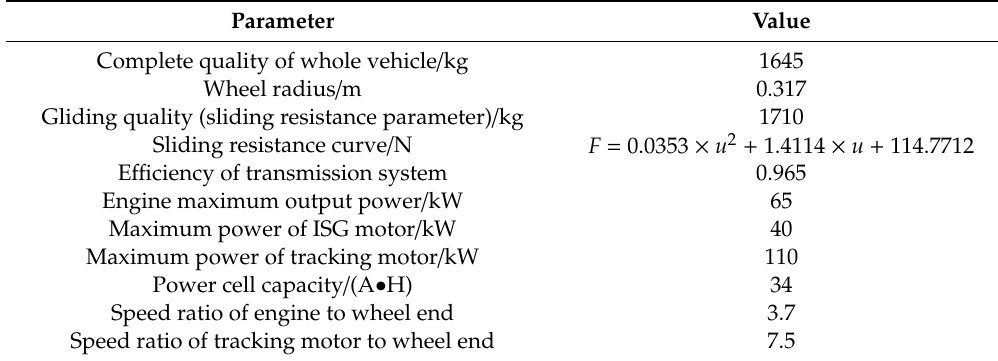
Table 1. Key parameters of series-parallel PHEV power